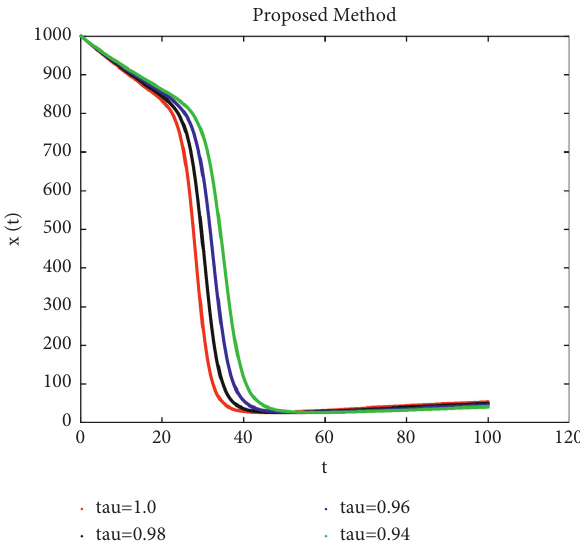
Figure 10: Dynamical behavior of concentration of uninfected (susceptible) cells at α � 1 and various fractal order under Mittag- Leffler kernel.